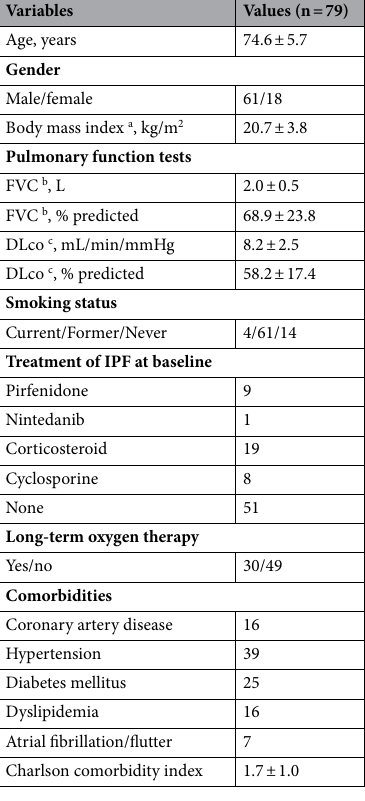
Table 1. Patient baseline characteristics and treatment for IPF. The values are expressed as mean ± standard deviation or actual number. DLco diffusing capacity for carbon monoxide; FVC forced vital capacity;